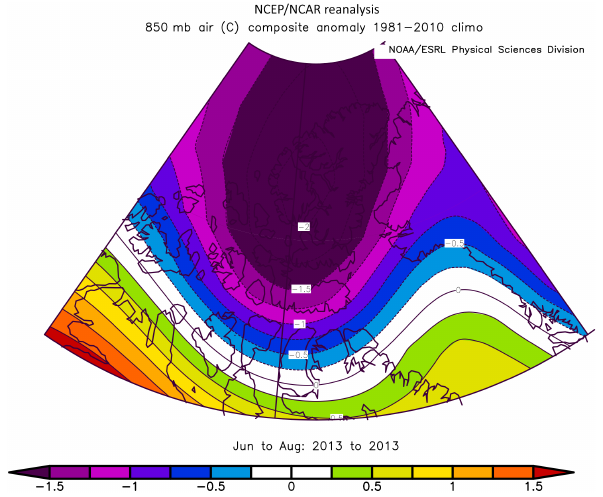
Figure 7. July 2015 air temperature anomalies at the 850hPa level from the NCEP/NCAR reanalysis relative to a 1981–2010